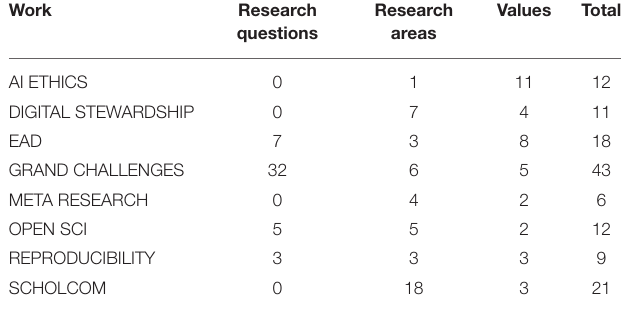
TABLE 2 | Extent of coded